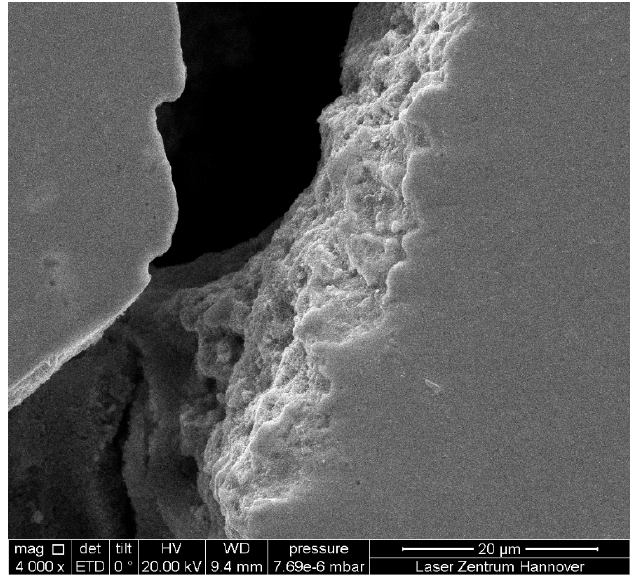
Figure 10. SEM-picture of a crack surface, centred position, ultrasonic amplitude: 4 µm.